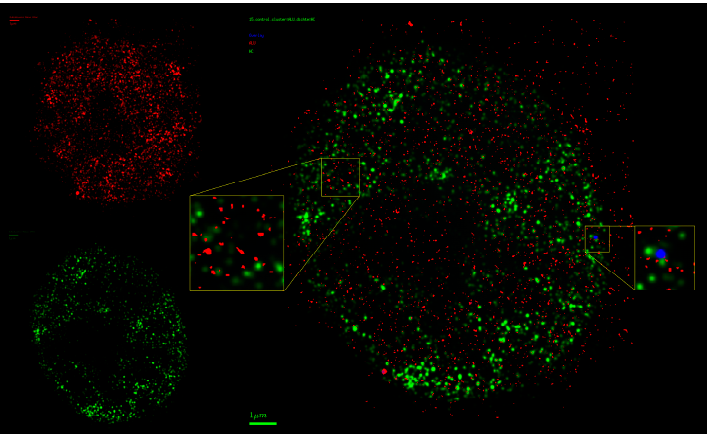
Figure 8. Visualization of the point matrix after two-color localization microscopy data acquisition. ALU COMBO-FISH oligonucleotides are labeled in red; heterochromatin methylation sites simultaneously labeled by antibodies (H3K9me3) are shown in green. The right image shows the merged visualization. The enlarged inserts demonstrate the exclusive arrangement of ALU sequences and heterochromatin target sites. In the whole image, only one (blue point) locus suggests a co-localization, which may be due to optical overlap (scale bar 1 μ m for the merged image).